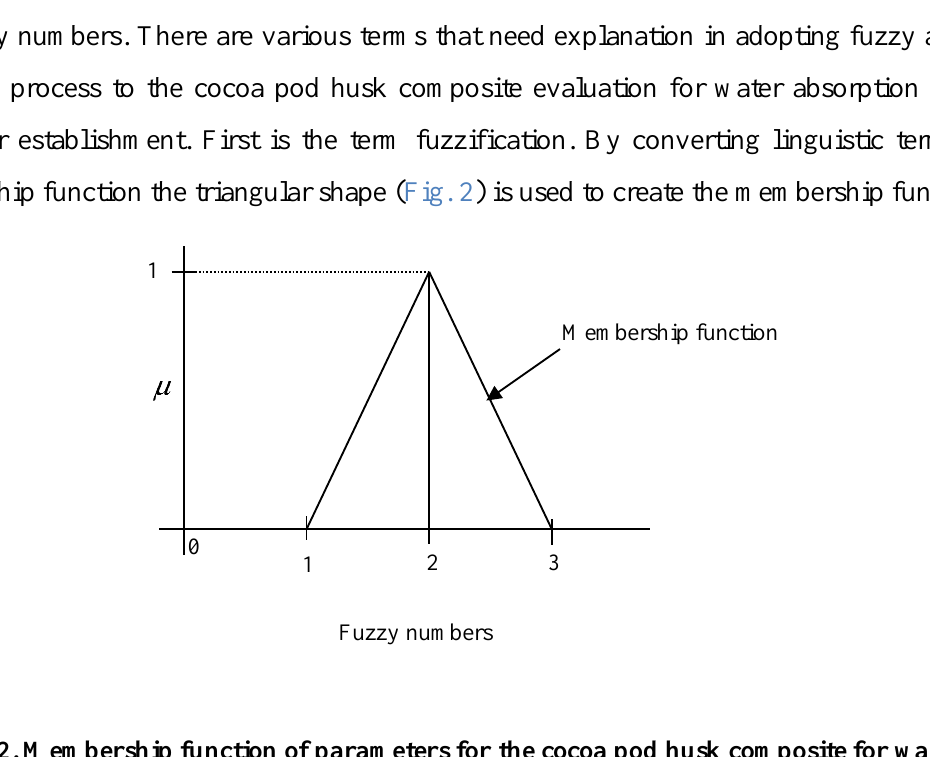
Fig. 2. Membership function of parameters for the cocoa pod husk composite for water absorption